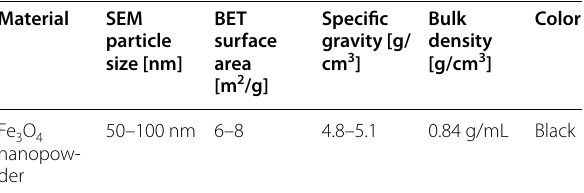
Table 2 Fe O nanopowder properties (data provided by 3 4 supplier)